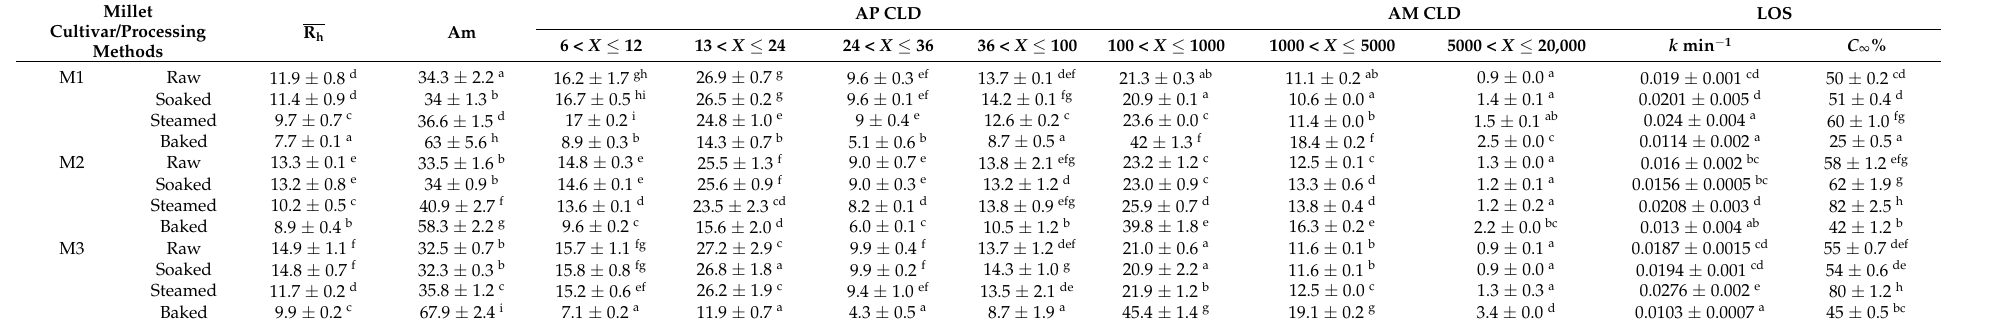
Table 1. The parameters of molecular size distribution, chain length distribution, and LOS linear fitting parameters of raw and different processed